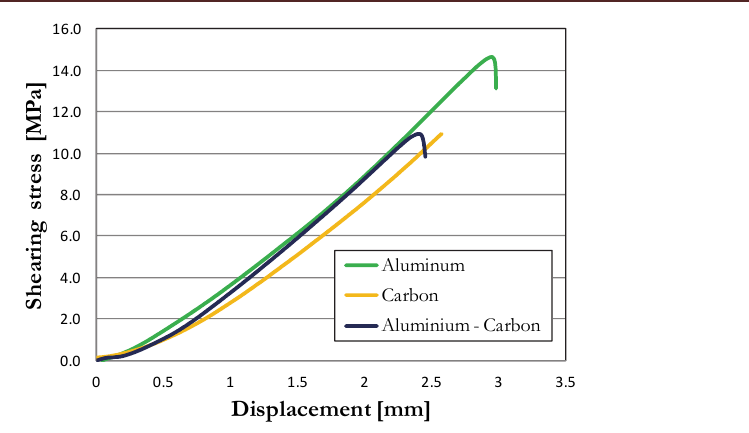
Figure 9: Influence of material combinations for 5 mm adherend thickness.